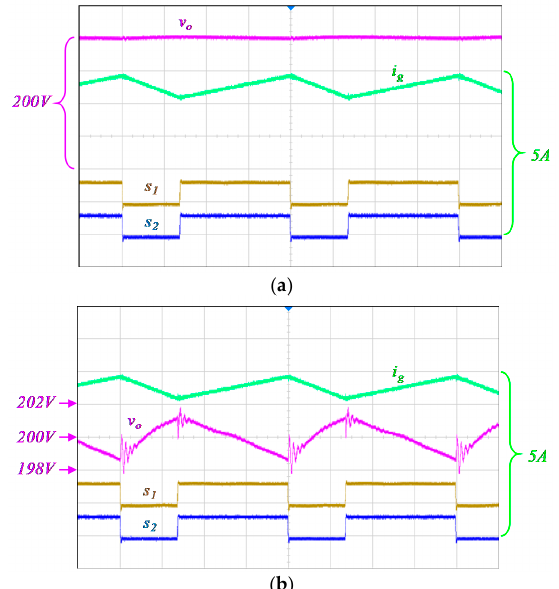
Figure 15. ( a ) The output voltage, input current, and firing signals when D = 0.6543 ( Vg ≈ 24 V) in the former strategy and ( b ) same signals with a zoom in the output voltage ripple. Electronics 2021 , 10 , x FOR PEER REVIEW